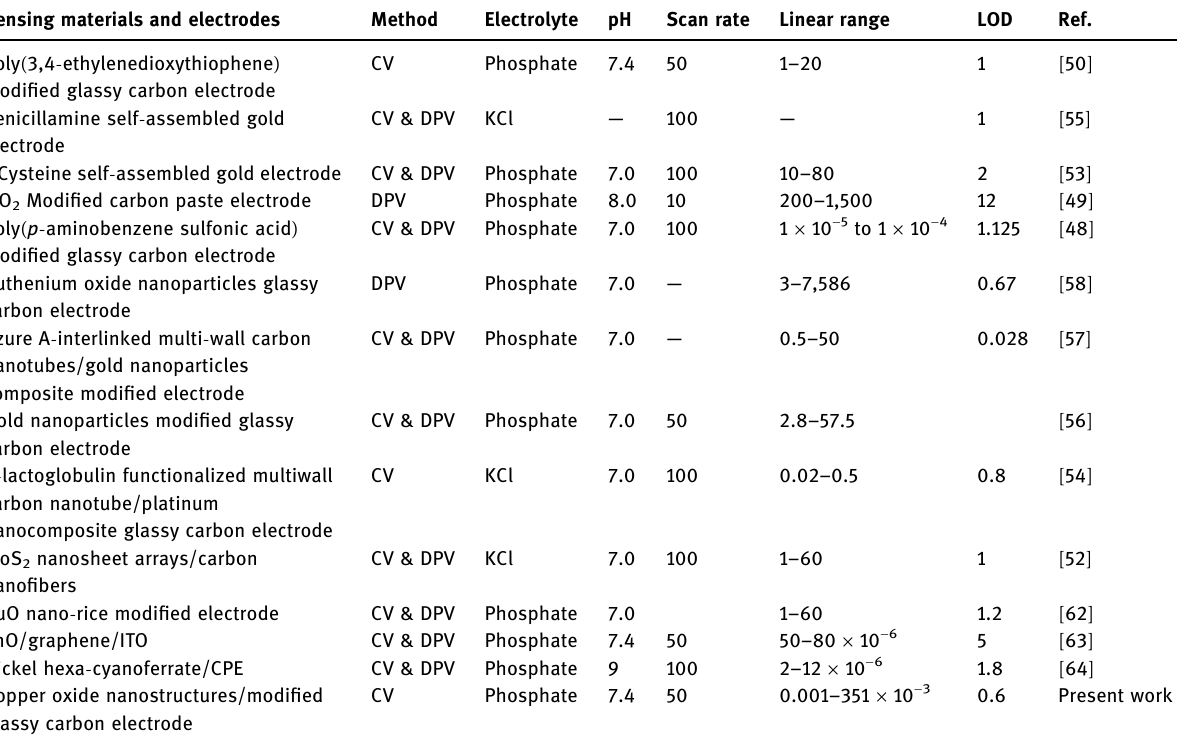
Table 2: Comparison study of reported sensors for uric acid detection Sensing materials and